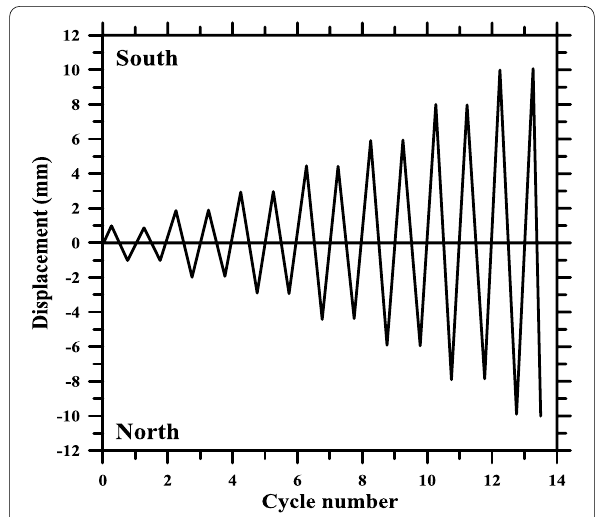
Fig. 6 Program for lateral force